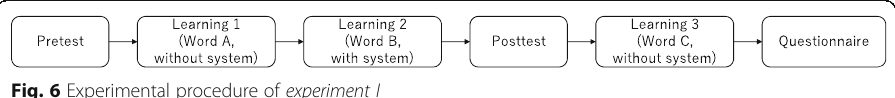
Fig. 6 Experimental procedure of experiment